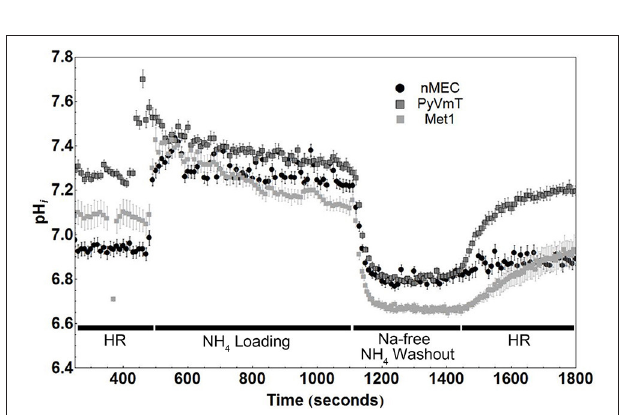
FIGURE 3 | Cancer cells (PyVmT tumor and Met1) have higher baseline intracellular pH and recover faster from the acid load than normal mammary epithelial cells (nMEC). Baseline pH i and rates of recovery of pH i when cells are challenged with an intracellular acid load (ammonium washout experiment). Markers on the plot represent the average and standard error of each pH i measurement. Number of cells measured: nMEC = 11, Met1 = 5, PyVmT = 10. Mean baseline pHi values were calculated between 250 and 400 sec: Met1 = 7.06 ± 0.05, PyVmT = 7.28 ± 0.02, nMEC = 6.94 ± 0.03. The baseline pHi values of both cancer cell types (PyVmT and Met1)